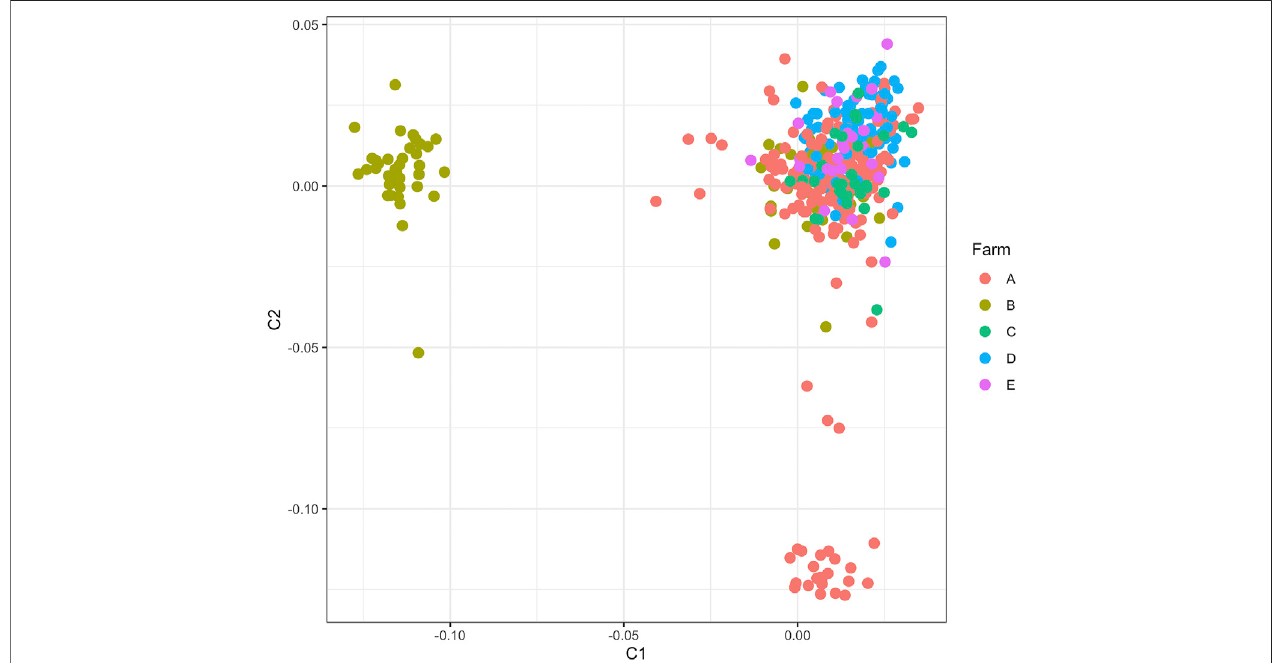
FIGURE 1 | Multidimensional scaling plot showing the fi rst two dimensions for 409 cows from the fi ve dairies used in the estimation of genetic correlation and genome-wide association analyses.